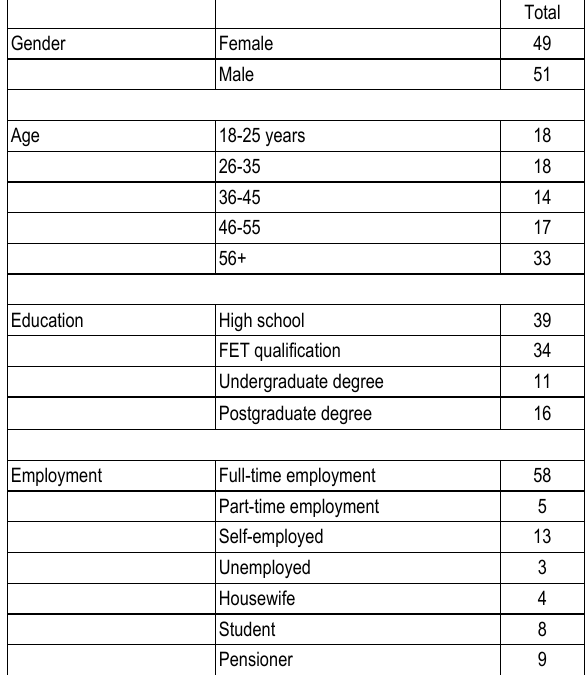
Table 1. Demographics of respondents